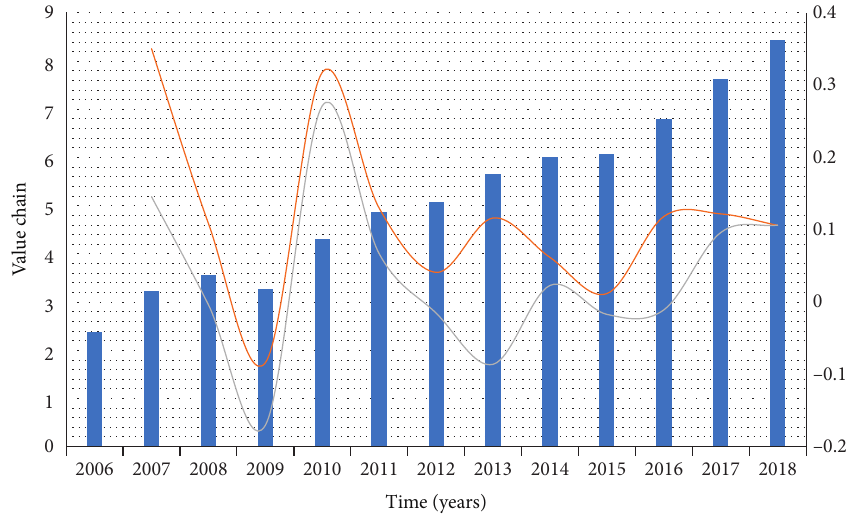
Figure 8: Value chain collaborative simulation